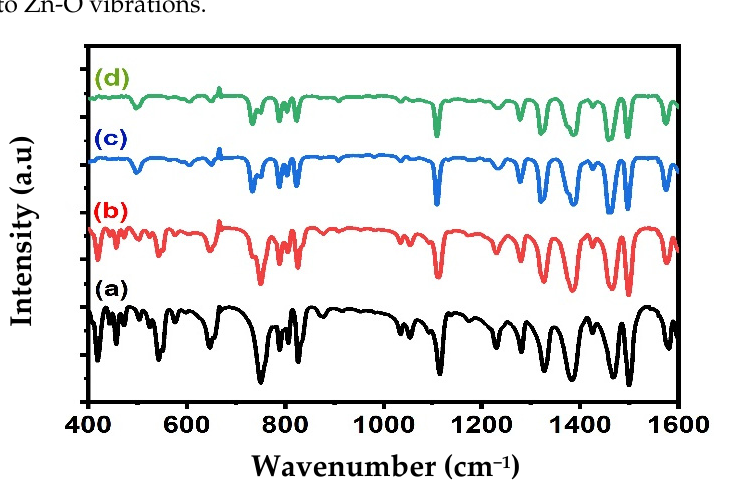
Figure 2. FTIR spectrum of ( a ) pure Alq3, ( b ) Alq3-10 wt.% ZnO QDs ( c ) Alq3-20 wt.% ZnO QDs ( d ) Alq3-30 wt.% ZnO QDs. Table 1. IR Vibrational modes in FTIR spectra of pure Alq3 and Alq3-ZnO nanohybrids [3]. Wavenumber (cm − 1 )